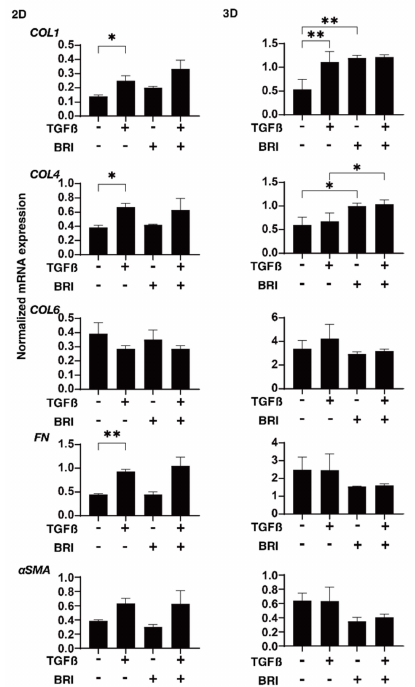
Figure 3. Effects of brimonidine (BRI) on the size ( A ) and hardness ( B ) of the TGF- β 2-treated 3D HTM spheroids.Regarding the 3D-cultured HTM for 6 days that were untreated (NT) or treated with 5 ng/mL TGF- β 2 (TGF β ) in the absence or presence of 10 µ M brimonidine (BRI), the mean sizes of the 3D HTM spheroids are plotted in panel A. Under these conditions, as the stiffness of the 3D HTM spheroid, the required force ( µ N) to deform the spheroid to the half diameter was measured using a micro-squeezer, and the force/displacement ( µ N/ µ m) values are plotted in panel B. “+” is reagents addition. “ − ” is reagents non-addition. These experiments were performed in triplicate using fresh preparations ( n = 10 and 15 for size measurement and stiffness analysis, respectively). Experiments were performed in triplicate using fresh preparations ( n = 4). Regarding the data, the arithmetic mean ± standard error of the mean (SEM) are shown (** p < 0.01, *** p < 0.005, ANOVA followed by a Tukey’s multiple comparison test).